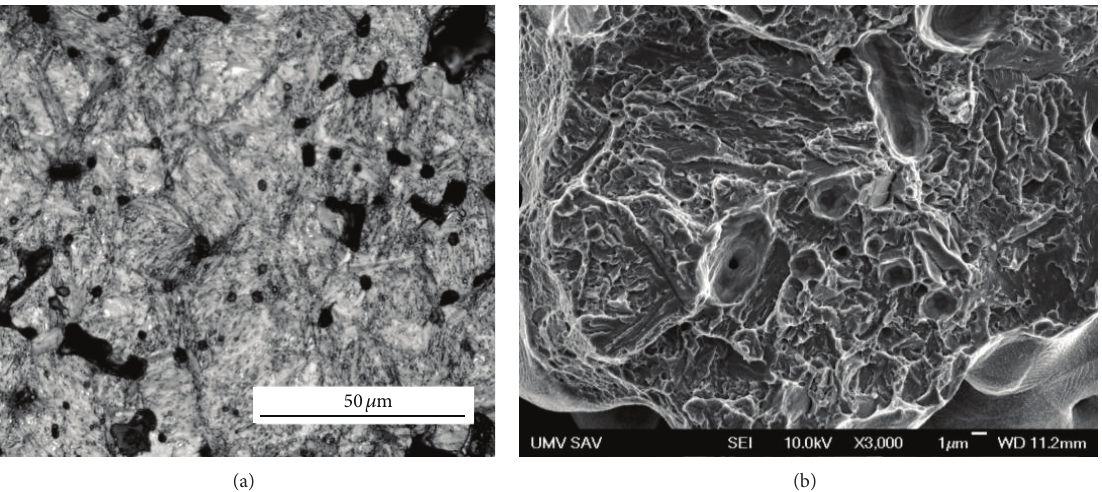
Figure 14: Microstructure and fracture surface of AstCrM + 0.8% C material sintered at 1200 ∘ C.